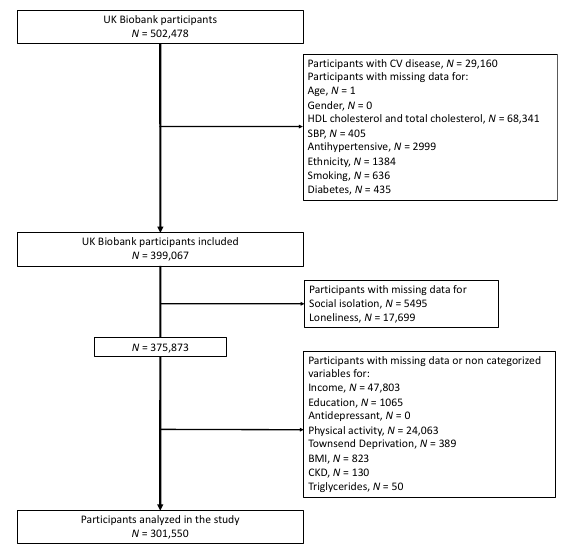
Figure 1. Flowchart. Figure 1.